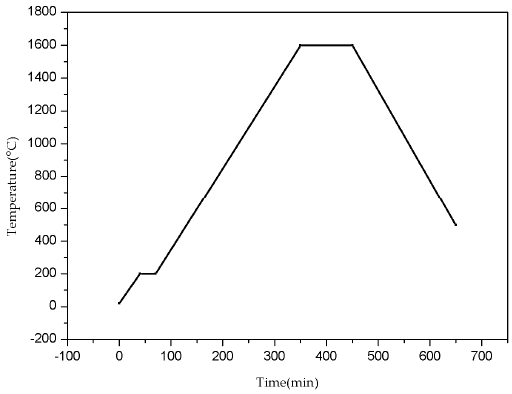
Figure 6. Muffle furnace temperature curve.